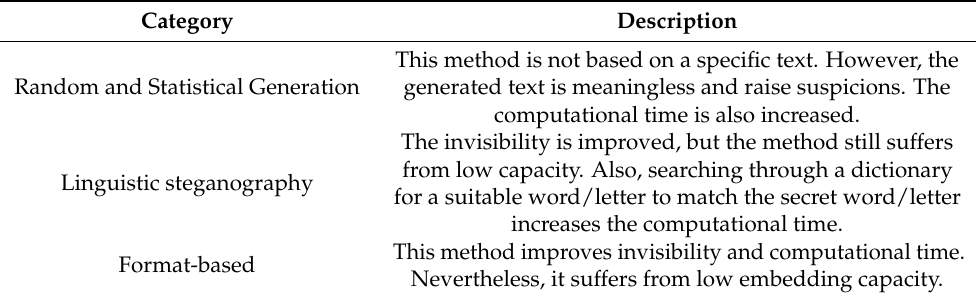
Table 5. The main differences between the 3